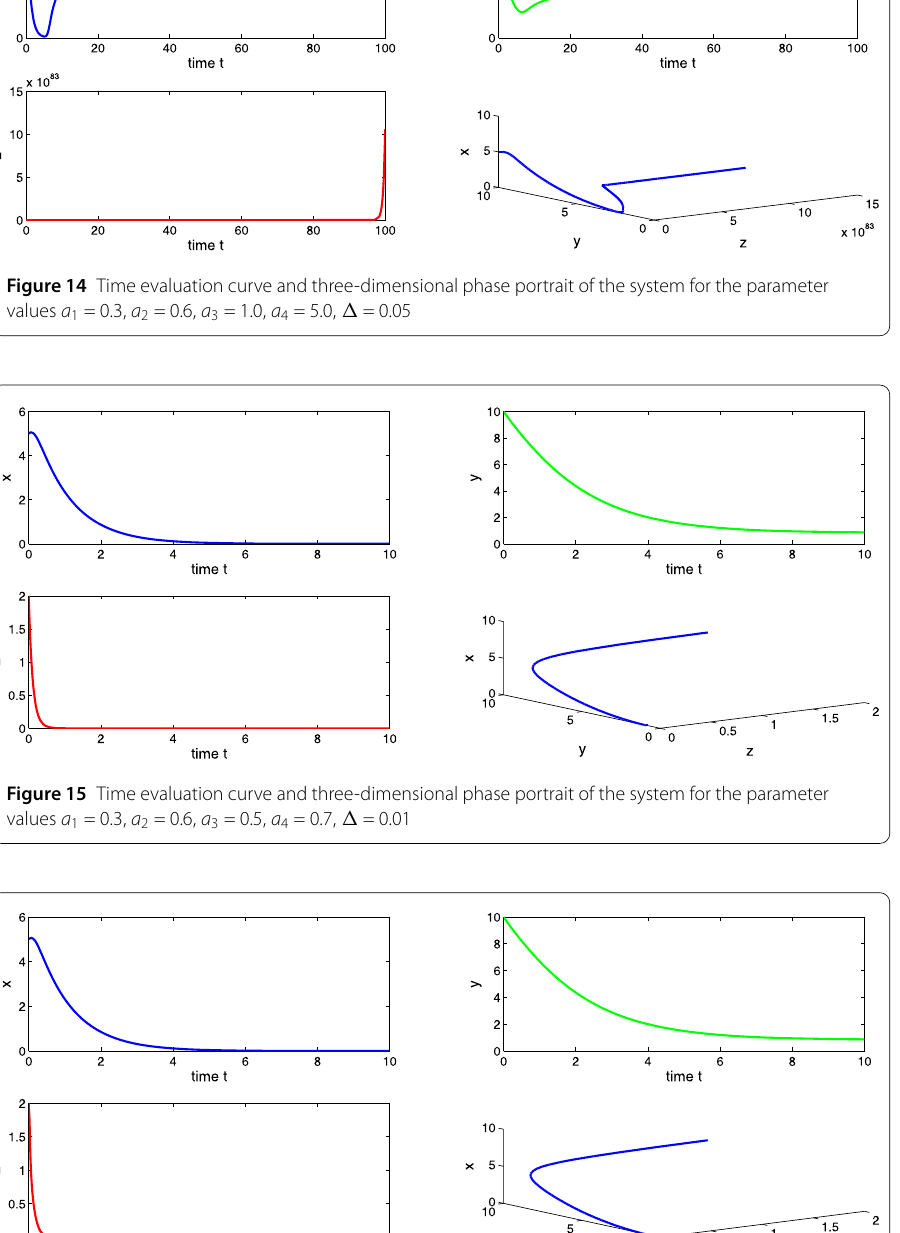
Choosing a 1 = 0.4, a 2 = 0.6, a 3 = 3.5, a 4 = 7.0, then a 2 > a 1 and 0 < a 3 < ( a 2 – a 1 ) a 4 , which indicates the existence of tumor-free equilibrium E 1 . At this equilibrium the system (2.2) shows unstable behavior. Figures 13 and 14 indicate that the number of tumor